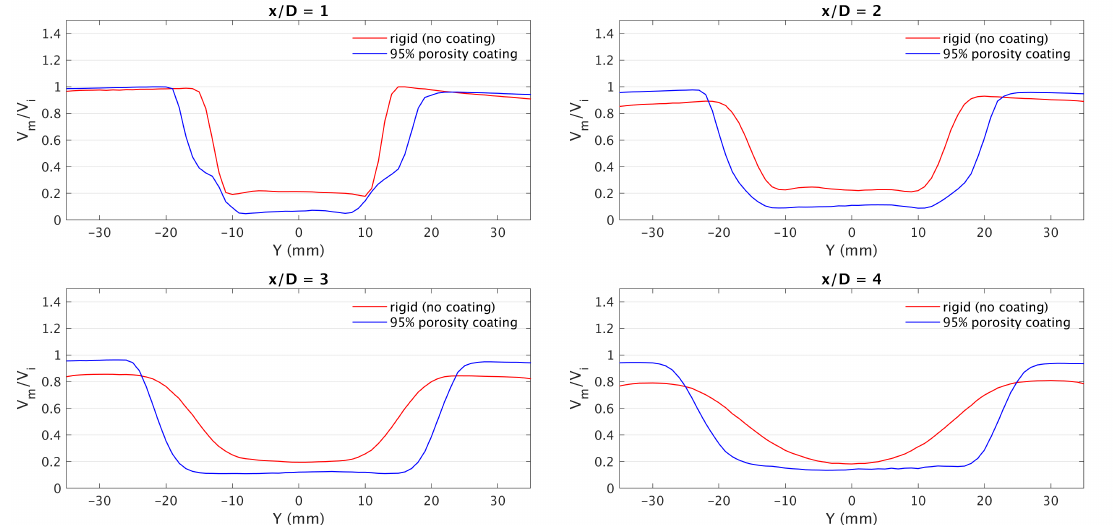
Figure 13. Velocity profiles for cylinders 1 and 5.